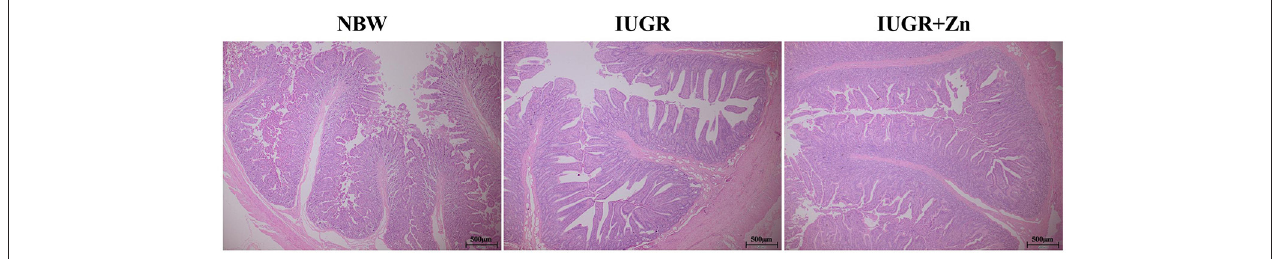
FIGURE 1 | Effects of dietary Nano-ZnO supplementation on the jejunal histomorphology in IUGR finishing pigs. All samples were stained with hematoxylin and eosin (H&E). Scale bar represents 500 µ m. NBW, images from normal birth weight pigs; IUGR, images from intrauterine growth restriction pigs; IUGR + Zn, images from IUGR pigs fed with diets supplemented with 600mg Zn/kg from Nano-ZnO.